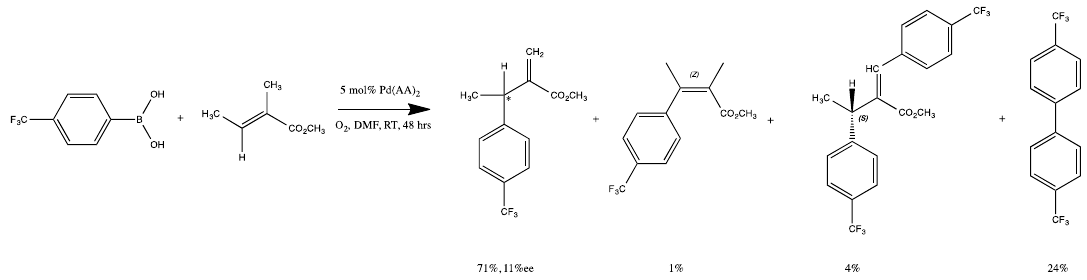
Figure 19. Reaction scheme and product distributions of the coupling reaction between 4- (trifluoromethyl)phenylboronic acid and methyl tiglate.